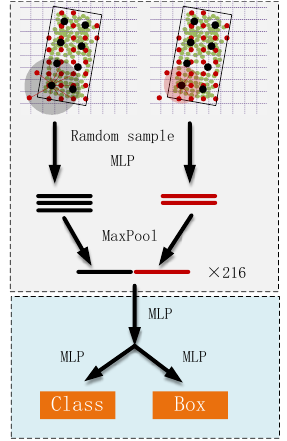
Figure 4. Multimodal Feature Attention (MFA) fusion module.